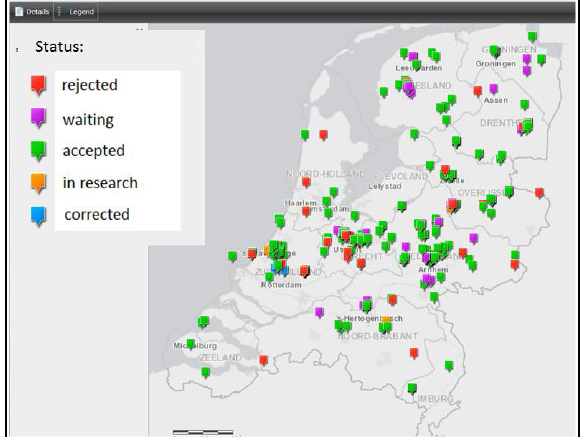
Figure 4. The status map application